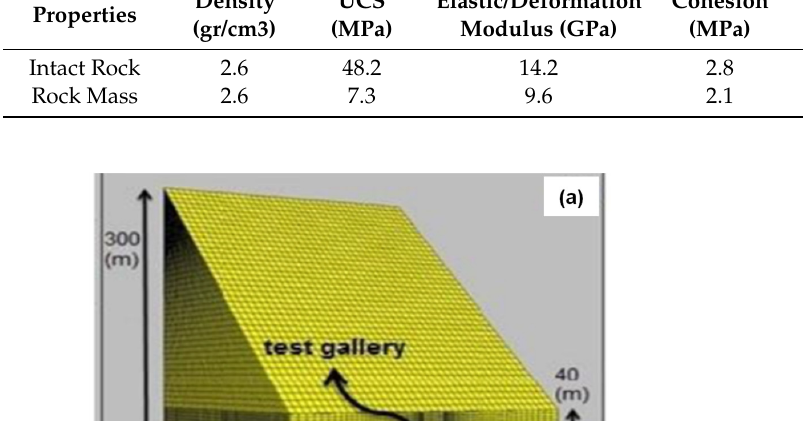
Table 1. Physical and mechanical properties of the Bazoft dam right abutment rock [19].